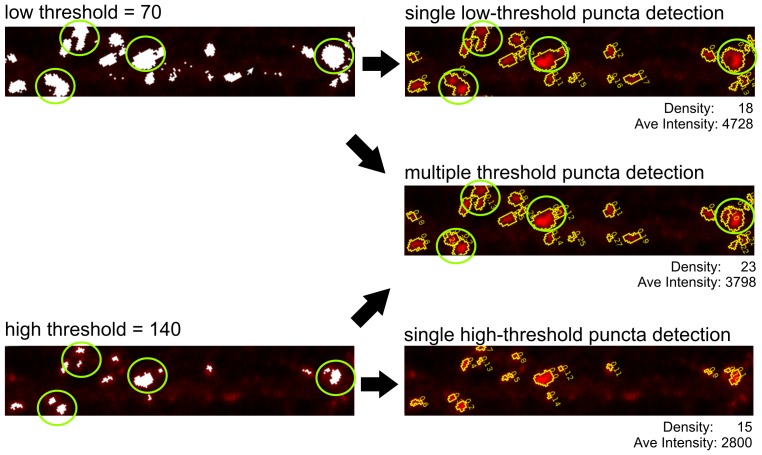
Improved puncta detection method of SynPAnal.An immunofluorescent image is shown to illustrate the differences between puncta detection at a single threshold versus puncta detection at multiple thresholds. A single round of puncta detection at a threshold of 70 returns 18 puncta with an average intensity of 4728 (top-right). At high threshold setting (140), 15 puncta were detected with an average intensity of 2800 (bottom-right). Green circles indicate multiple adjacent puncta that are detected as single clusters when using a low single threshold, but are actually two puncta at higher threshold setting (140), which resulted in an under-estimation of puncta numbers. SynPAnal uses multiple rounds of puncta detection starting at a threshold of 255 and ending at a threshold of 70 (center-right) and detected 23 puncta with an average intensity of 3798.